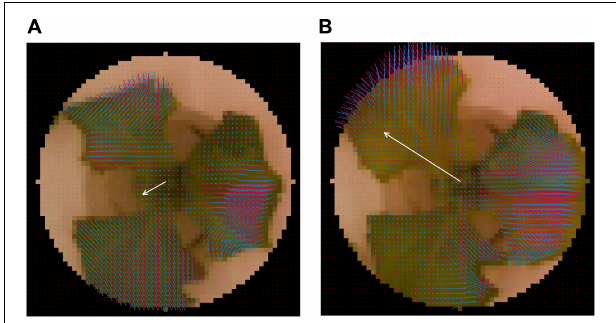
FIGURE 3 | Visualization result of normal-vector analysis. Visualization result for single lettuce at (A) t = 168 h and (B) t = 180 h. Blue vector represents p ijk Red vector represents n ijk . White vector represents N k . The visualization of N k was performed by at 20 × the original N k